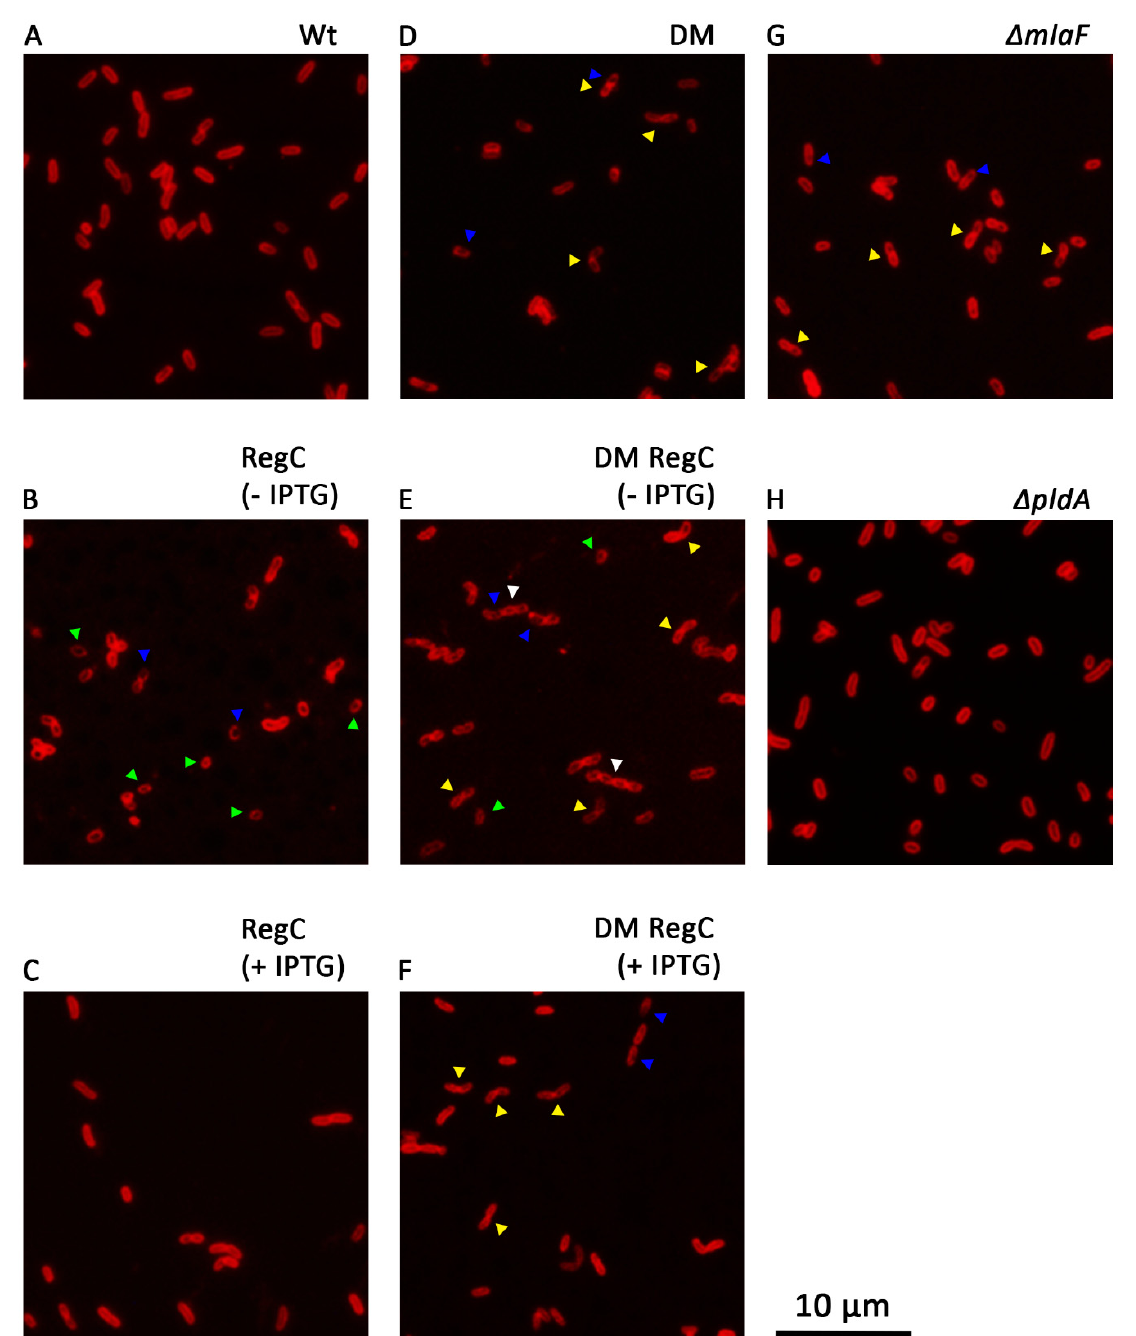
Figure 3. Morphology of B. pertussis cells visualized by fluorescence microscopy. Representative